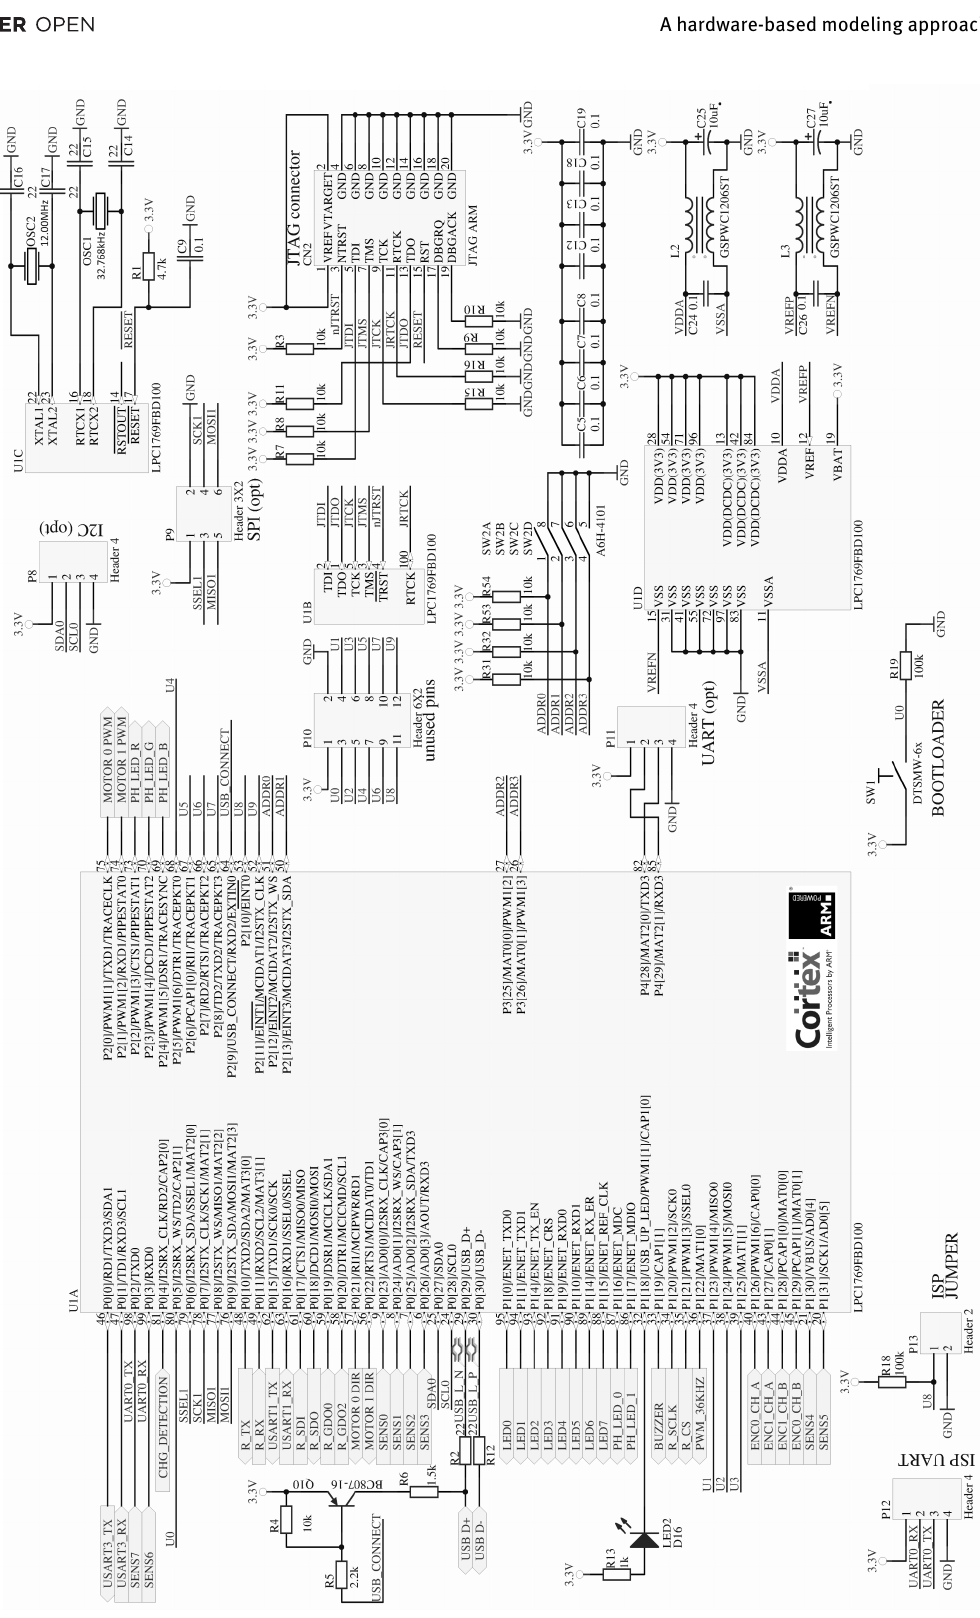
Figure 5: Main MCU